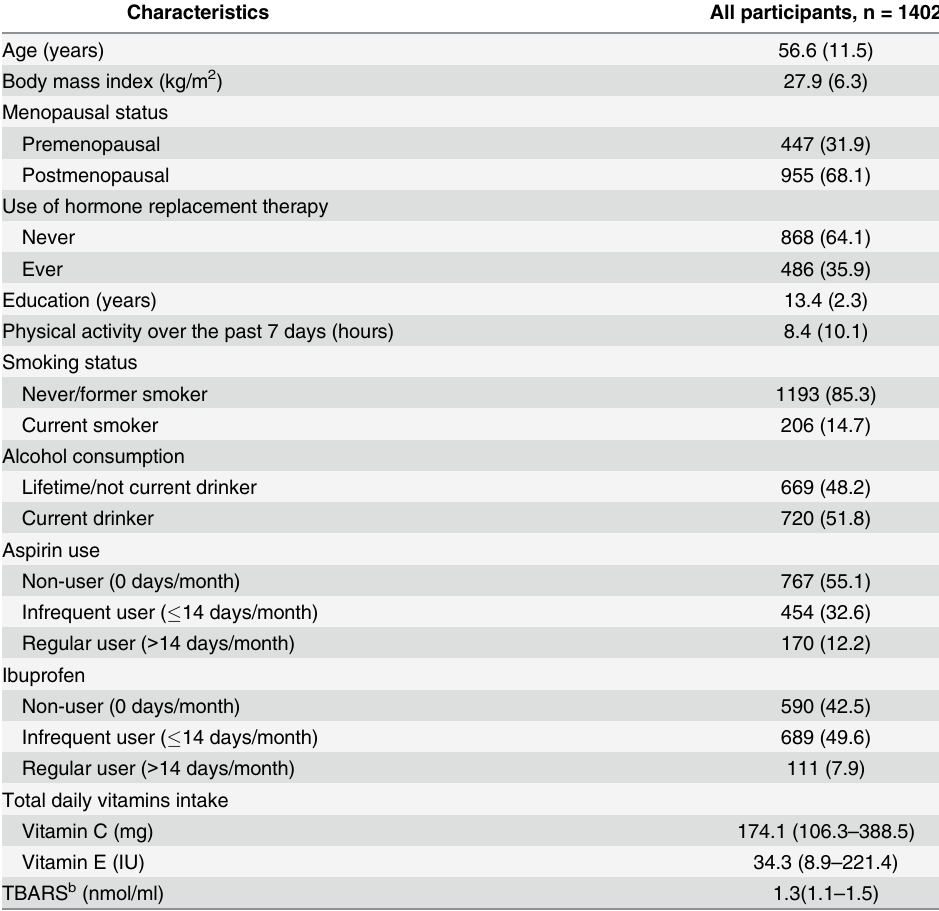
Table 1. Characteristics of the participants, WEB study controls, Erie and Niagara Counties, 1996 – 2001 a